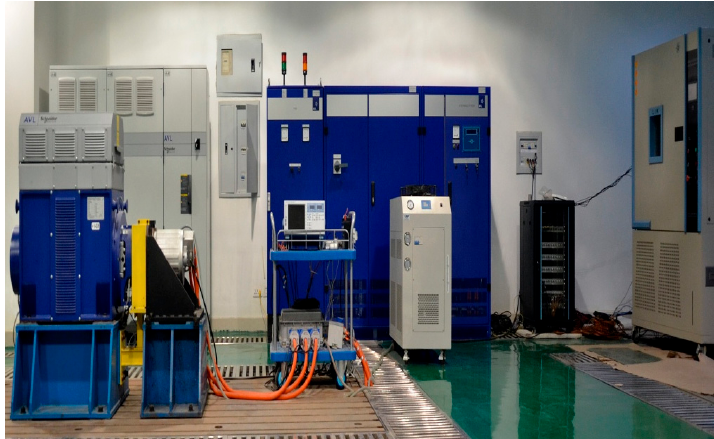
Figure 3. AVL E-storage test equipment.